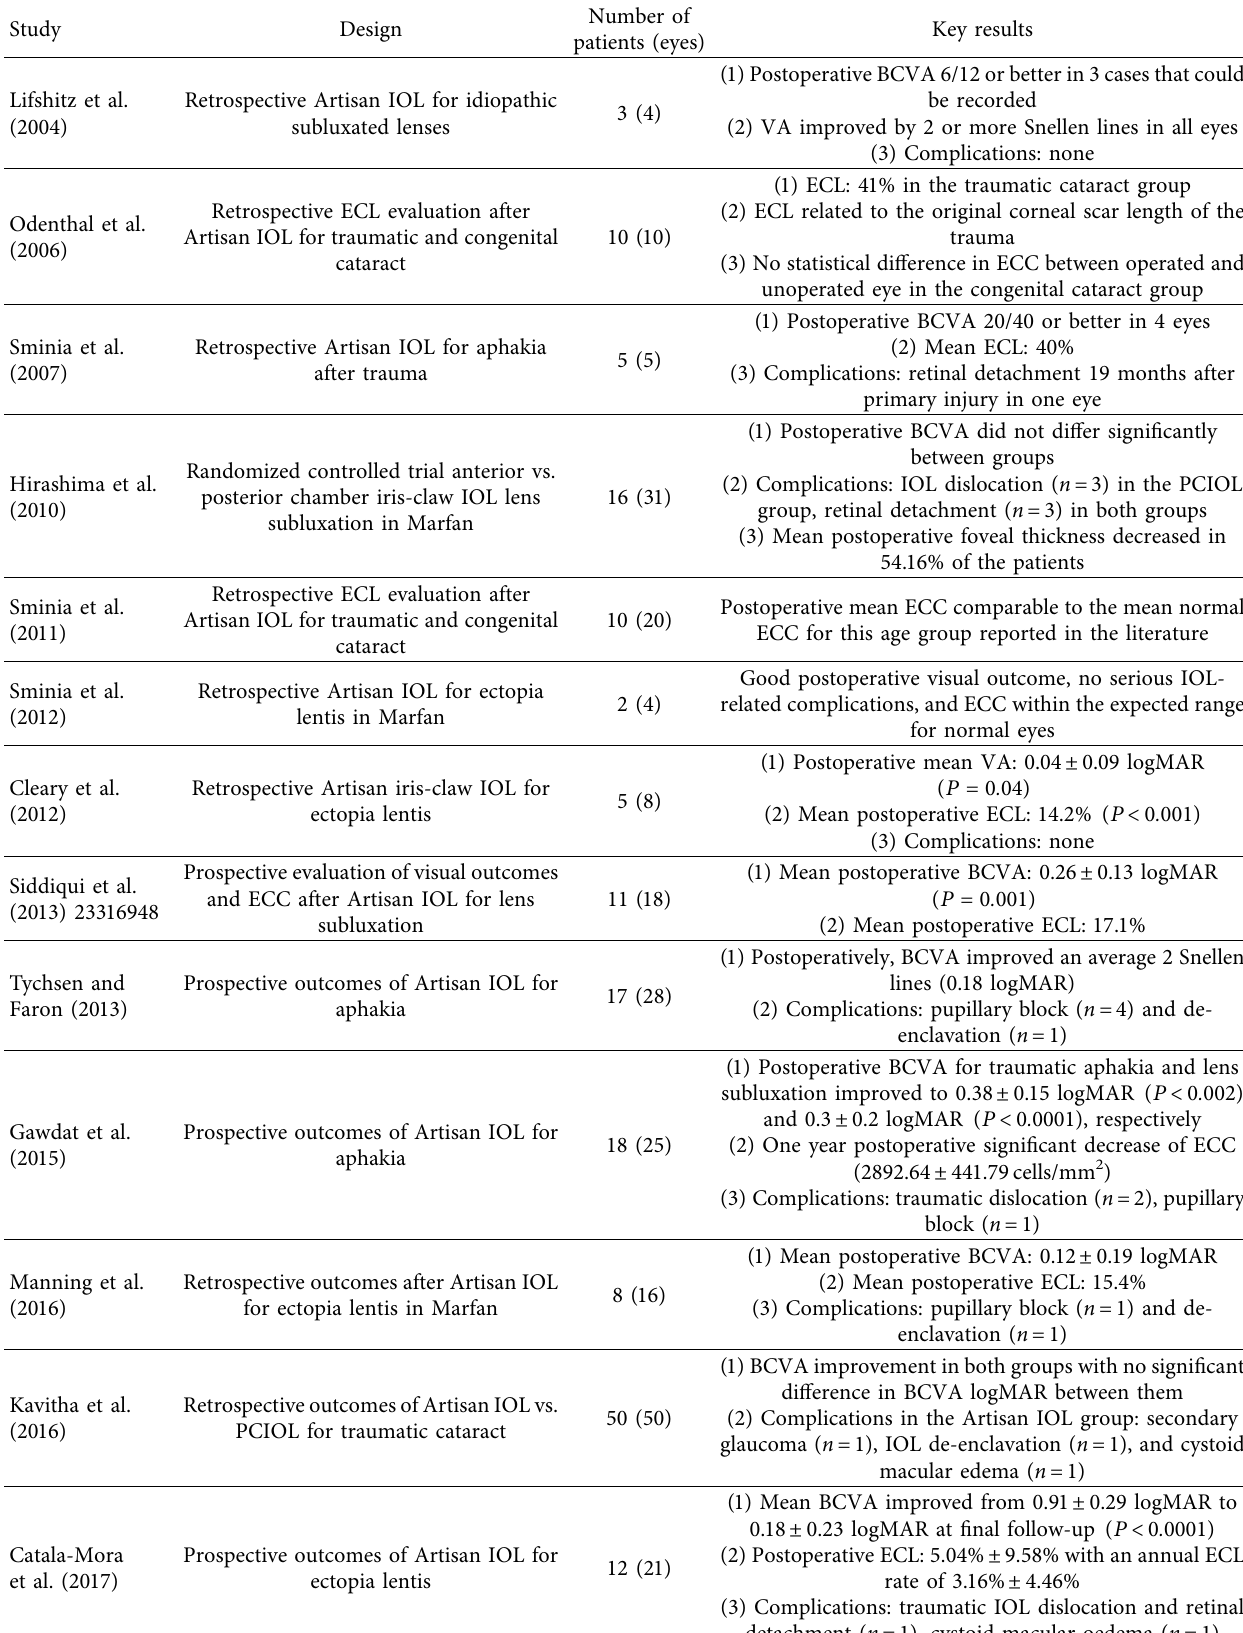
Table 2: The most important studies of Artisan IOL in paediatric aphakic